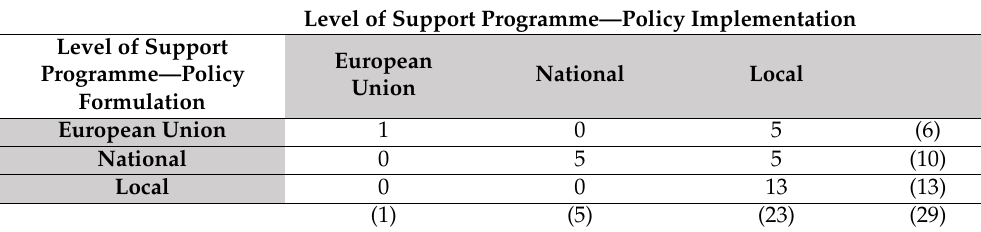
Table 4. Administrative level of support programmes—level of policy formulation and